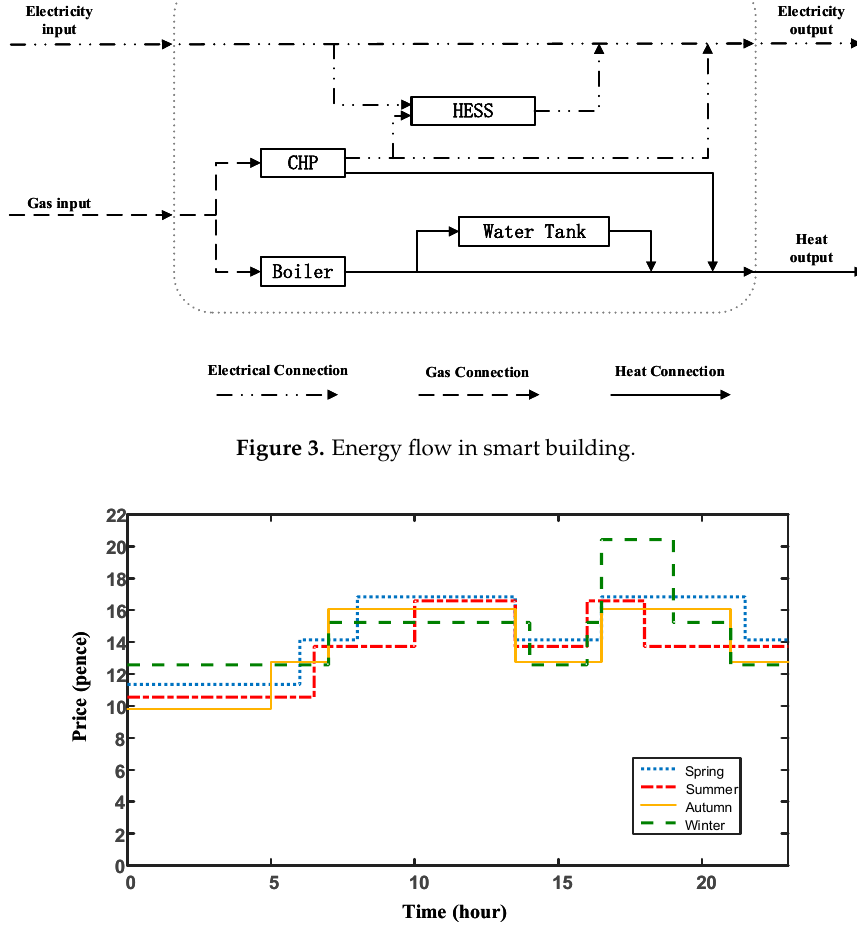
Figure 4. Daily electricity price in different seasons [17].